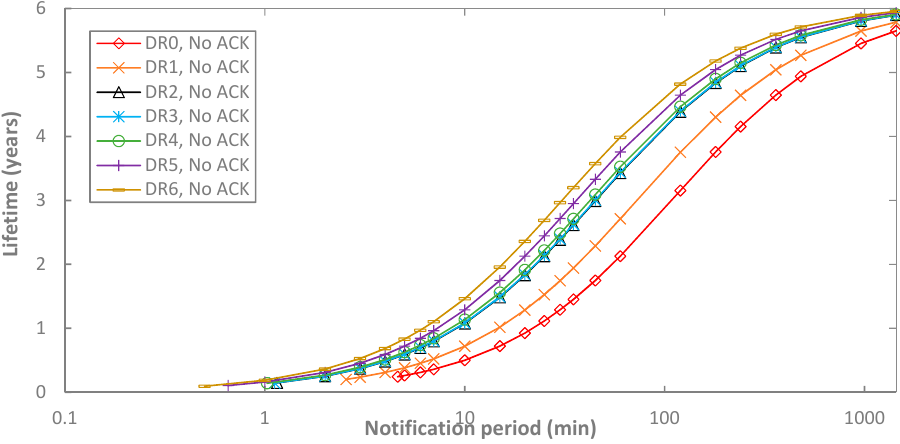
Figure 13. End-device lifetime in unacknowledged transmission, as a function of T Notif , and for different DR settings.